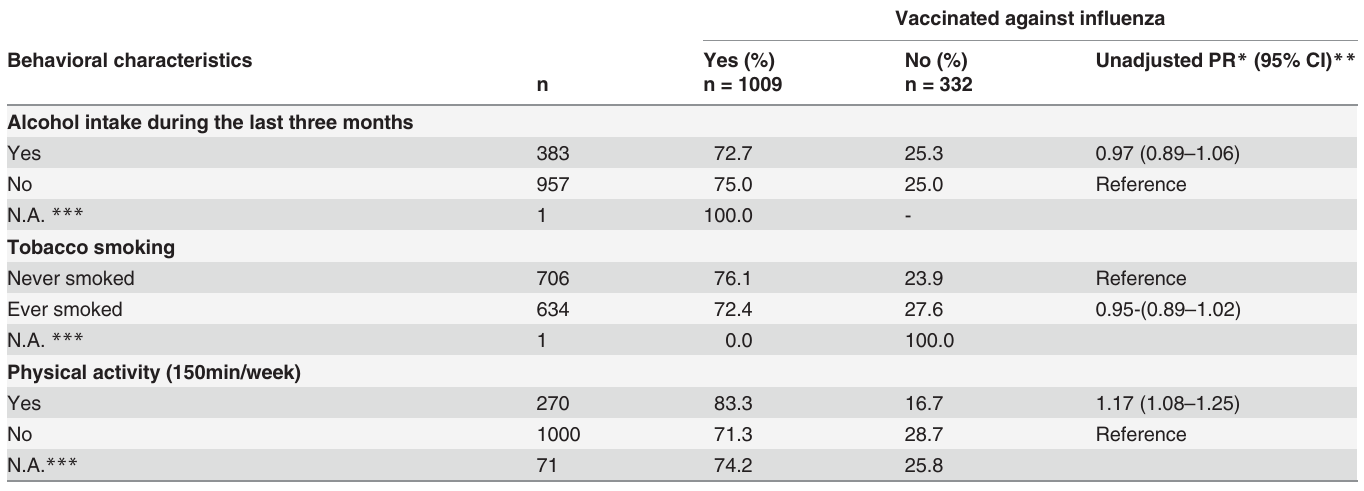
Table 2. Influenza vaccination among the elderly (n = 1,341) by behavioral characteristics. S ã o Paulo, Brazil,